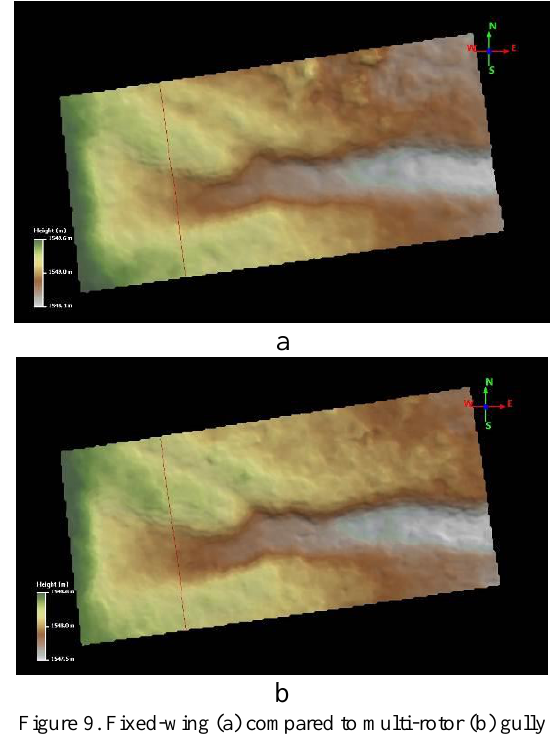
Figure 9. Fixed-wing (a) compared to multi-rotor (b) gully DTM. Note the red lines that indicate the position of the gully profile.